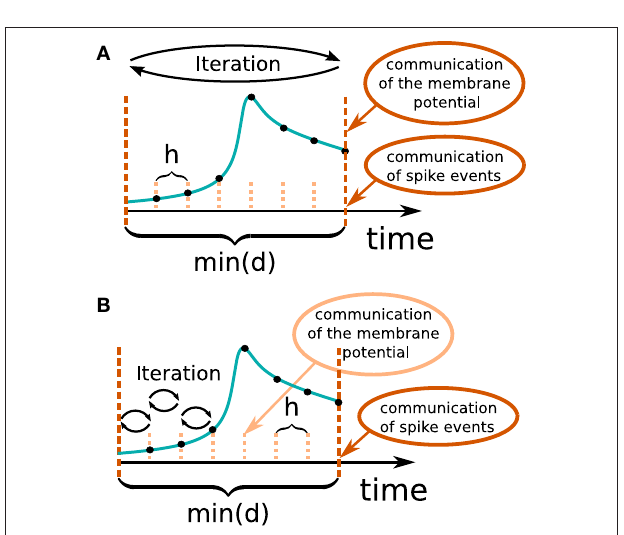
FIGURE 3 | Two communication strategies using the waveform relaxation technique in a time-driven simulator. (A) The membrane potentials are communicated in intervals equal to the minimal synaptic delay. (B) Potentials are communicated in every computation time step h